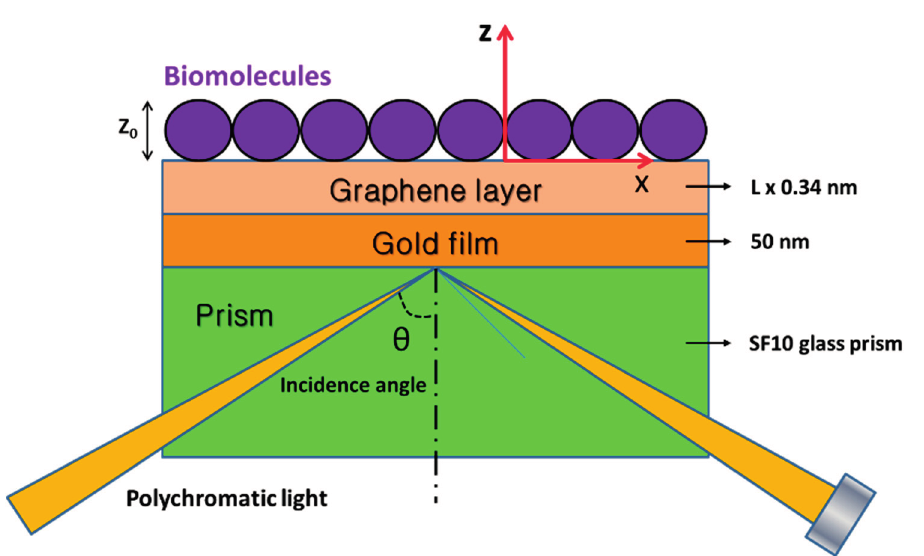
Figure 9. The configuration of the proposed graphene-on-gold surface plasmon resonance biosensor based on generalized N-Layer model, where the gold film is deposited on top of a SF10 glass prism. A polychromatic light wave passes through the prism and is internally reflected on the prism-gold interface, creating an evanescent wave which penetrate the metal film (50 nm) and propagate along the x direction with propagation constant. The light propagation constant matches the surface plasmon polariton (SPP) propagation constant across the interface by controlling the incident angle θ . Plots of totally reflected intensity versus incident angle yield a peak, which is known as SPR angle. The graphene-on-gold surface plasmon resonance: prism | Au (50 nm) | graphene (L × 0.34 nm) | sensing medium, where L is the number of graphene layers, and Z 0 = 100 nm is the thickness of the biomolecule layer. Adapted from